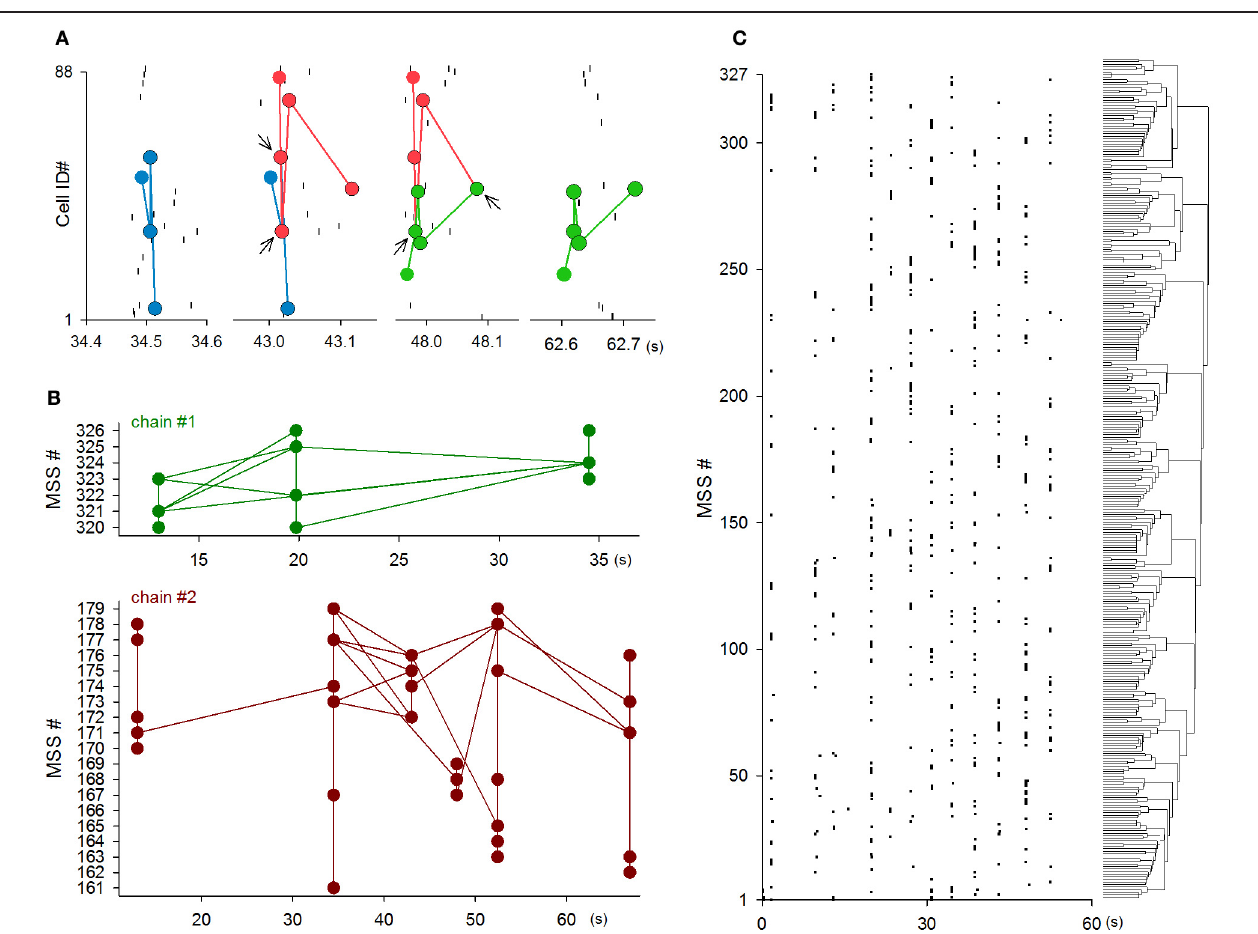
FIGURE 12 | Flexibility and complexity of MSSs. (A) An example of an MSS chain. Spikes that consisted of MSSs were partially shared (i.e., relayed) by other MSSs. Arrows indicate the shared spikes, referred to here as core